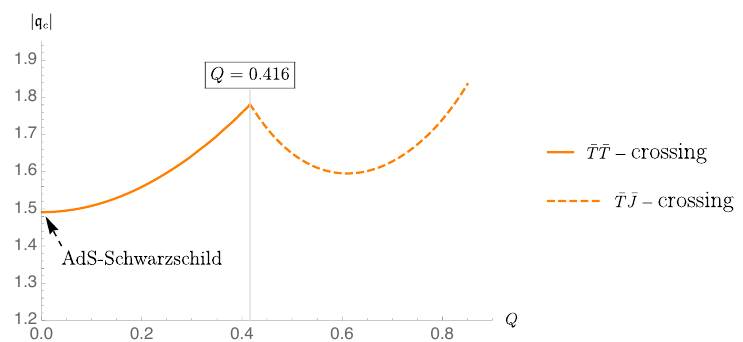
Figure 11. Radius of convergence of the derivative expansion associated with w shear versus Q in the spin 1 channel. At small values of Q spectrum of transverse master current is fully